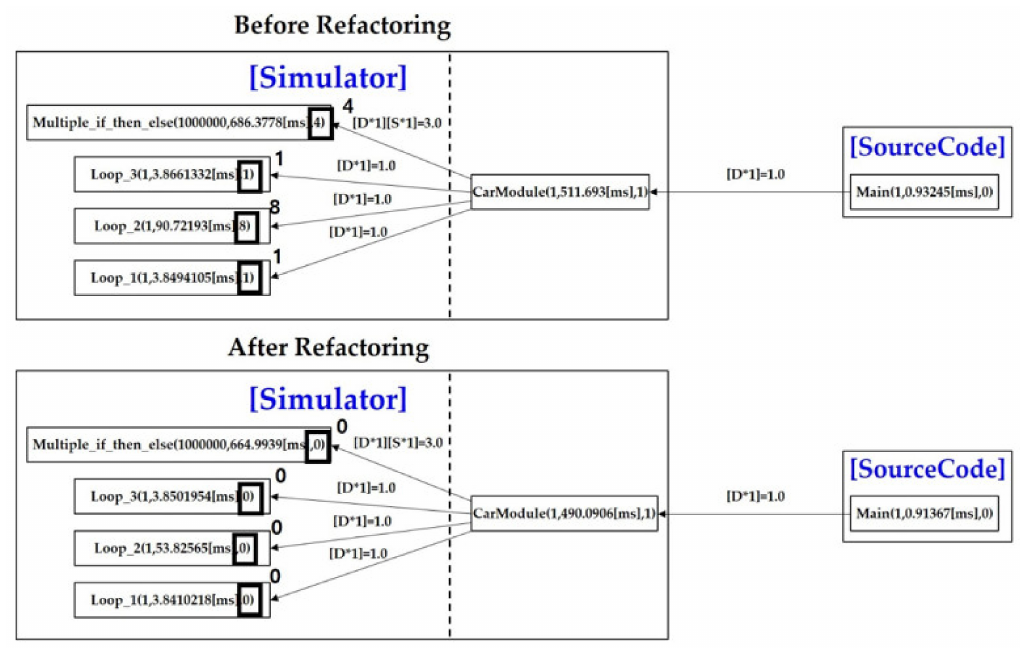
Figure 18. Code performance view between ‘before’ and ‘after’ refactoring.